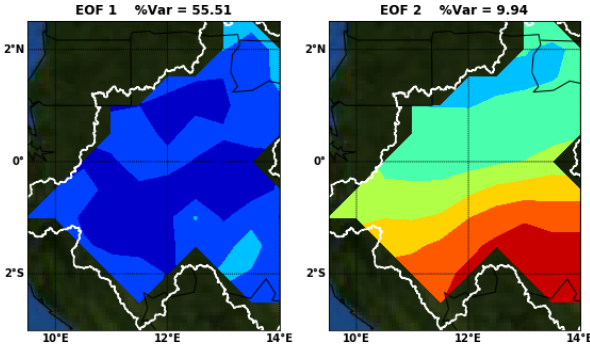
Figure 2. First two components of EOF analysis of rainfall in the ORB from 1940 to